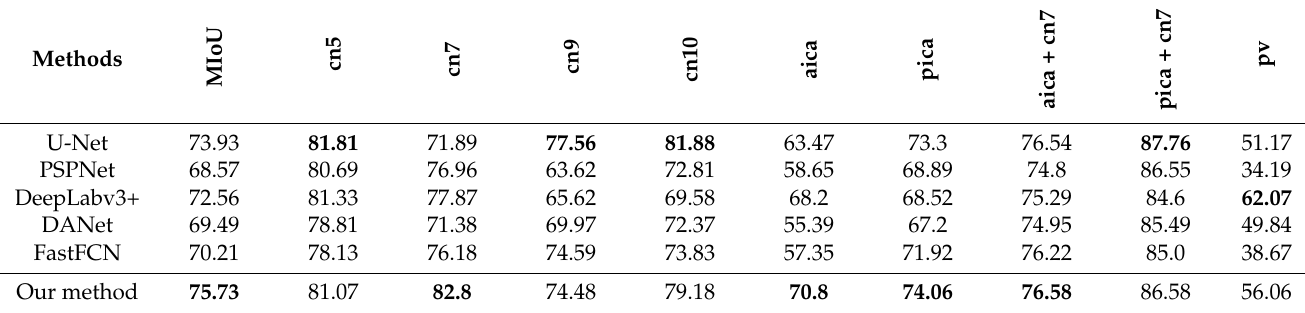
Table 4. Pre-class results on the test set. Our method outperforms existing approaches and achieves 75.73% in MIoU.